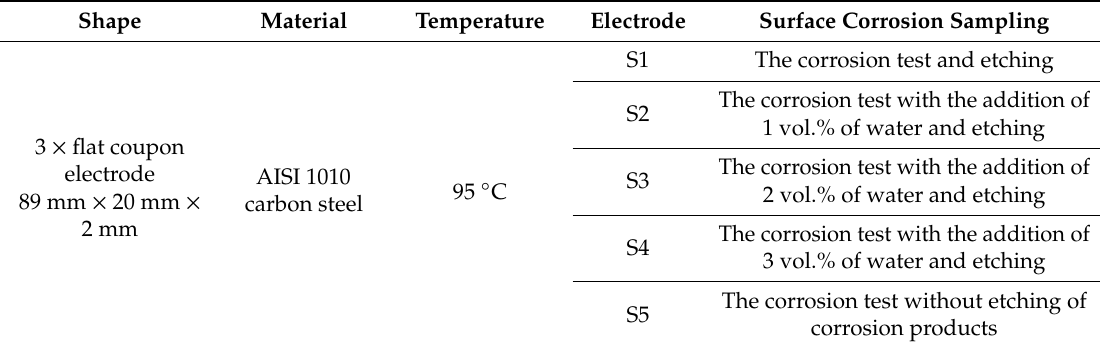
Table 2. Description of the analyzed AISI 1010 carbon steel samples in sulfolane-containing